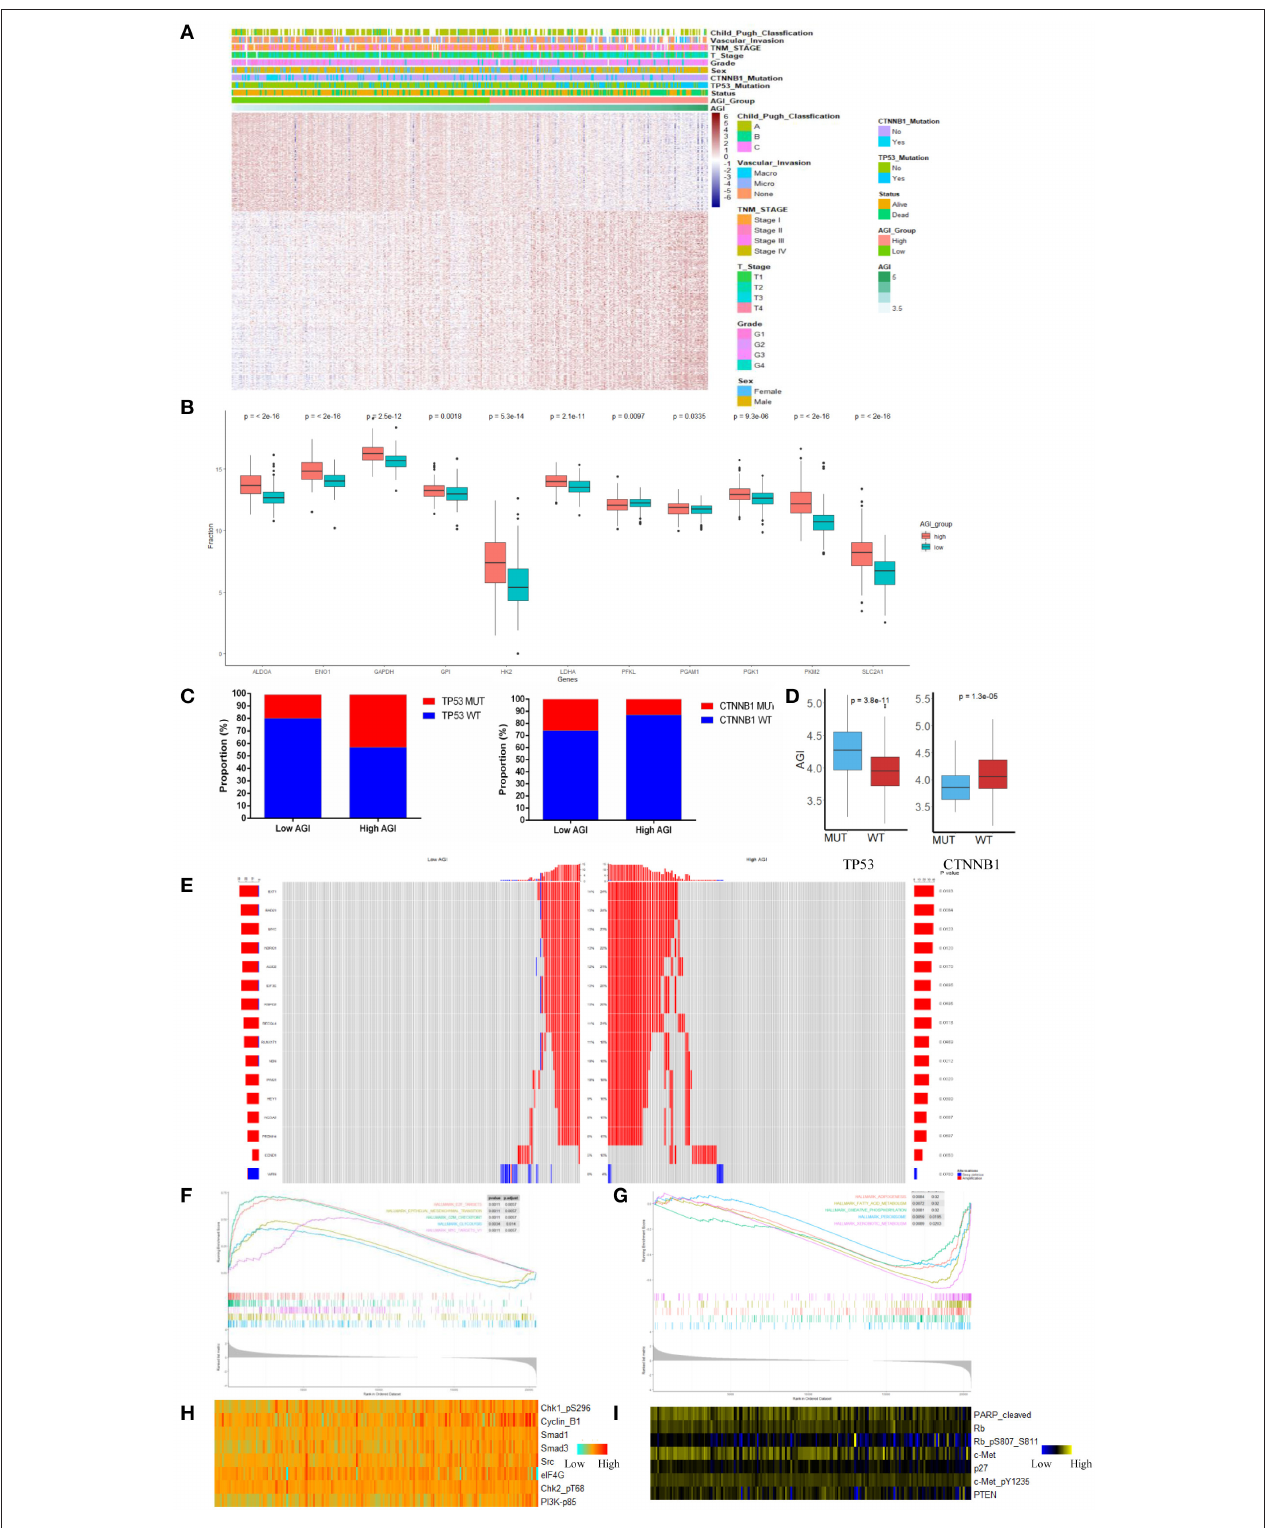
FIGURE 3 | The landscape of biological processes and characteristics of the aerobic glycolysis index (AGI) subgroups. (A) Heatmap of common differentially expressed genes based on the expression data in the high and low AGI groups. (B) Box plots showing the expression of the selected glycolysis-related genes in The